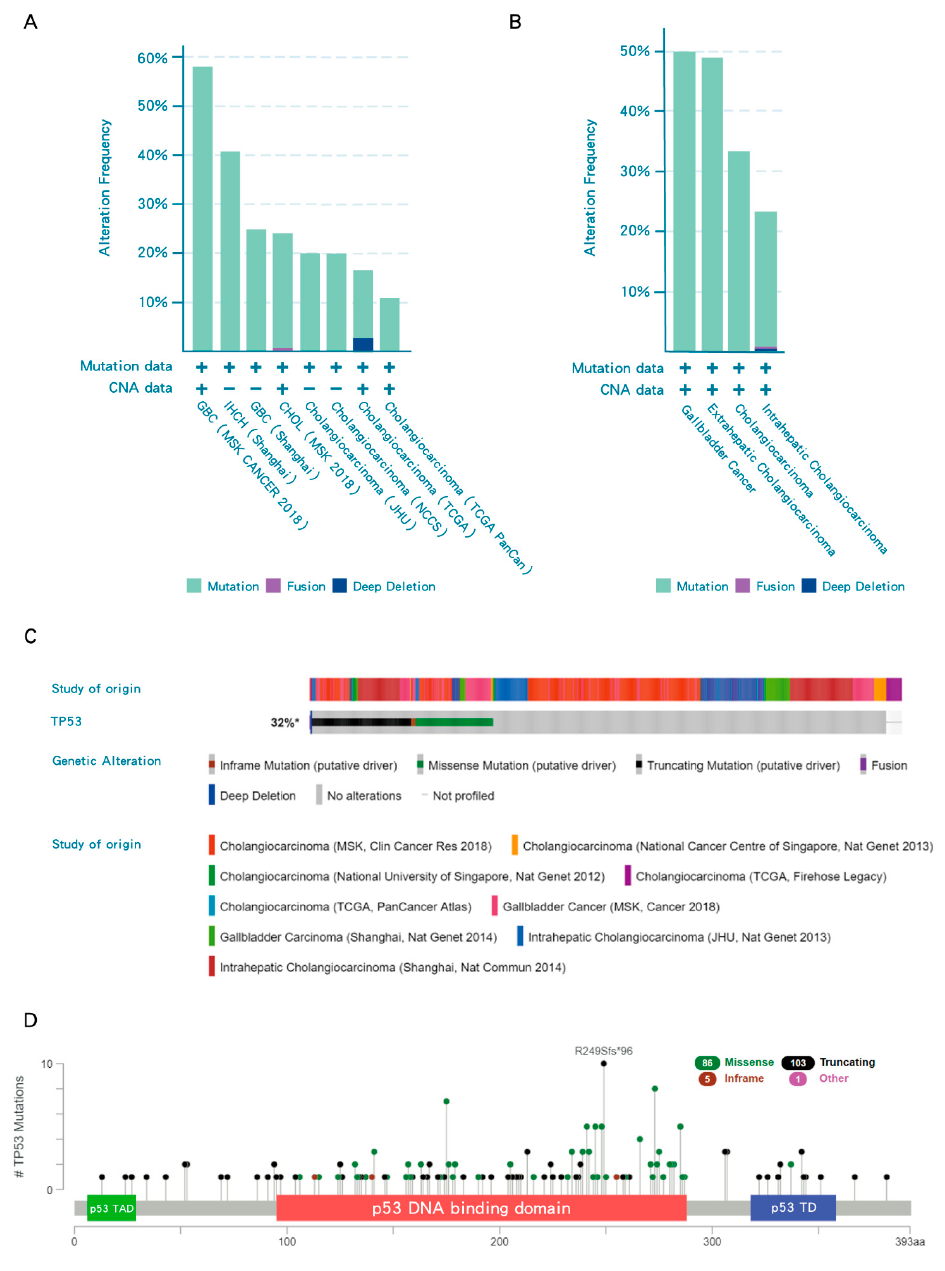
Figure 2. TP53 mutations in biliary tract cancers (BTCs). ( A ) Frequency of TP53 mutations